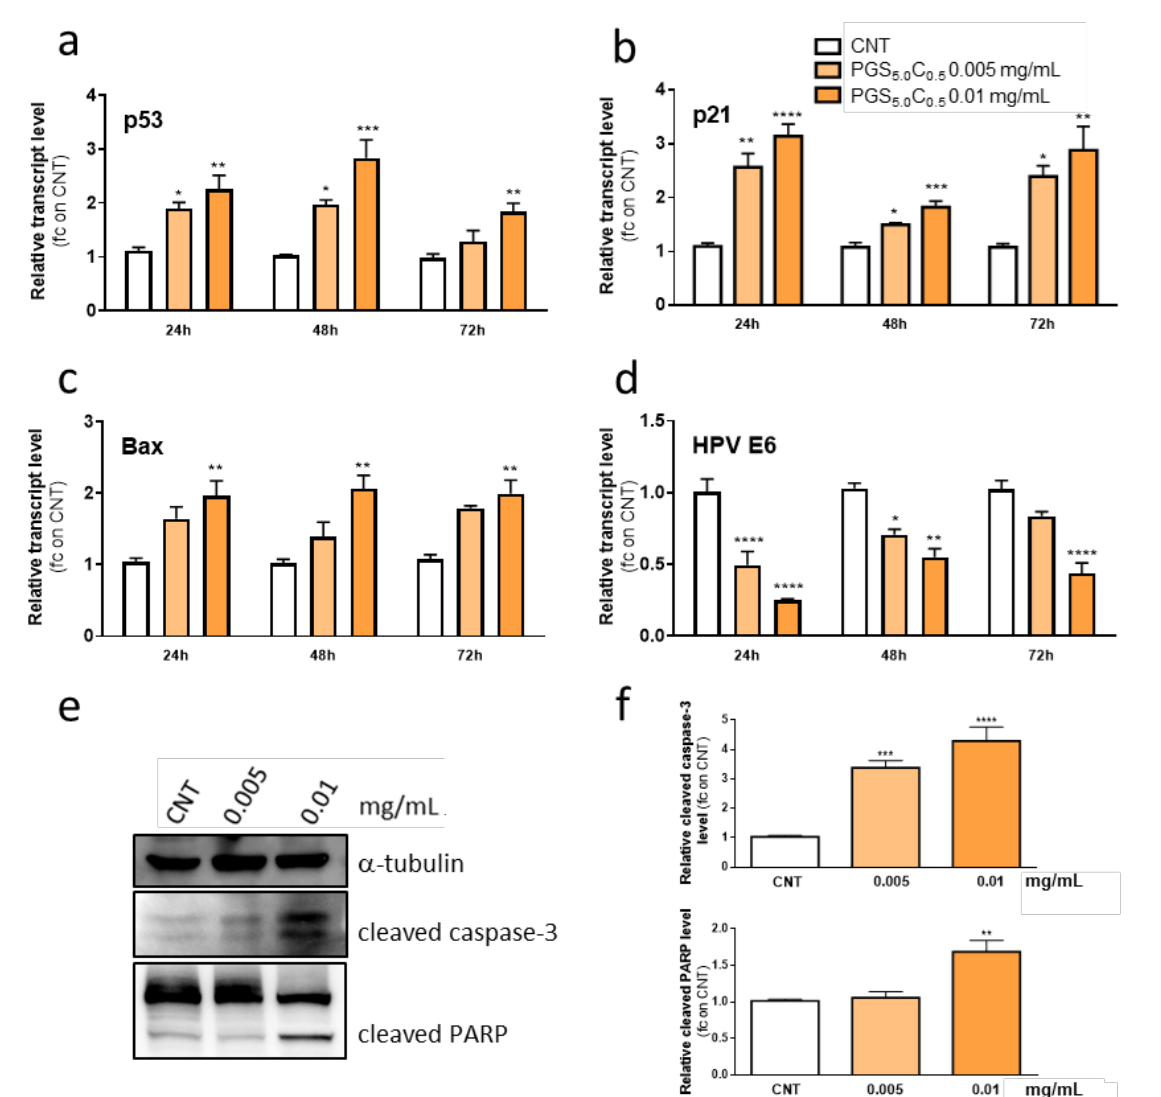
Figure 8. Effect of curcumin-loaded PGS-NPs on the induction of apoptosis. Real-time RT-PCR analysis of transcript levels of p53 ( a ), p21 ( b ), Bax ( c ) and HPV E6 genes ( d ) in HeLa cells treated with 0.005 or 0.01 mg/mL of PGS 5.0 C 0.5 for 24, 48 and 72 h. Each transcript level is expressed as fold change (fc) with respect to control samples treated with vehicle (CNT). Values are means ± SEM (n = 6) ( e ) Western blot panel and ( f ) relative quantification of cleaved caspase-3 and PARP levels in HeLa cells treated with 0.005 or 0.01 mg/mL of PGS 5.0 C 0.5 for 72 h. Data were analyzed with ImageJ and normalized to α -tubulin and expressed as fold change over CNT. Values are means ± SEM (n = 3). * p < 0.05, ** p < 0.01, *** p < 0.001, **** p < 0.0001 indicate significant differences (two-way ANOVA followed by Tukey’s multiple comparisons test) versus CNT. CNT (blank): Control; PGS 5.0 C 0.5 (light